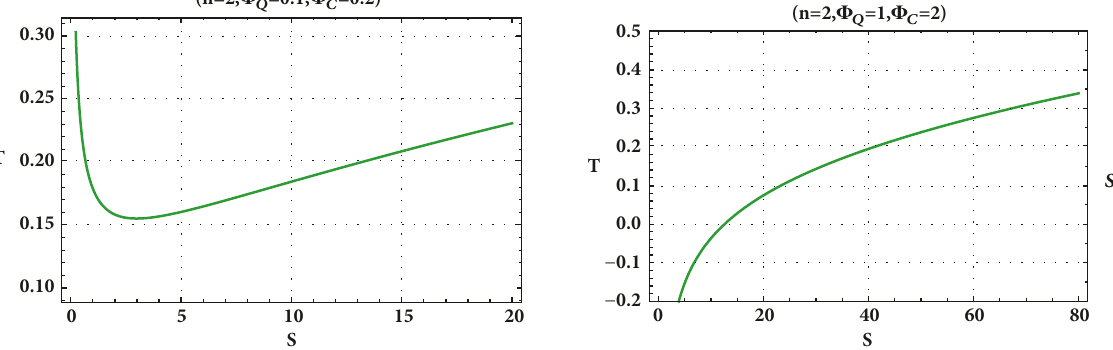
Figure 3: The temperature as a function of the entropy for different potentials. (Left) Φ 2 𝑐 + Φ 2 𝑄 < 1 . (Right) Φ 2 𝑐 + Φ 2 𝑄 > 1